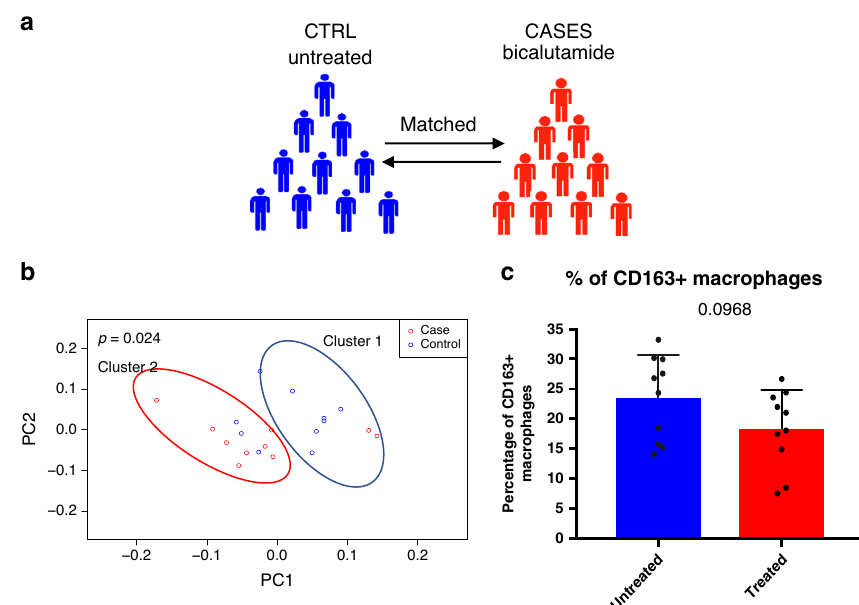
Fig. 9 Anti-androgen treatment reduces the number of TAMs in the prostate. a Graphic visualization of the study design: 10 untreated PCa patients and 10 PCa patients treated with the anti-androgen bicalutamide prior to prostatectomy were matched for Gleason pathology score, serum PSA level, age and TNM classi fi cation. b PCA visualization of the Kmean unsupervised cluster analysis. Group 1 and Group 2 classify patients in untreated and treated patients, respectively. Numerical data in Supplementary Table 3. P = 0.024, Pearson correlation test was used to calculate the p -value with a cutoff for signi fi cance of 0.05. c Quanti fi cation of the percentage of CD163 + TAMs in the entire population of HLA-DR + and/or CD14 + cells in prostatectomy specimen of untreated and bicalutamide treated patients. Datapoints show individual patients and error bars show the s.e.m. p = 0.0968. Paired parametric Student ʼ s t test was used to calculate the p -value with a cutoff for signi fi cance of 0.05. Source data are provided as a source data fi